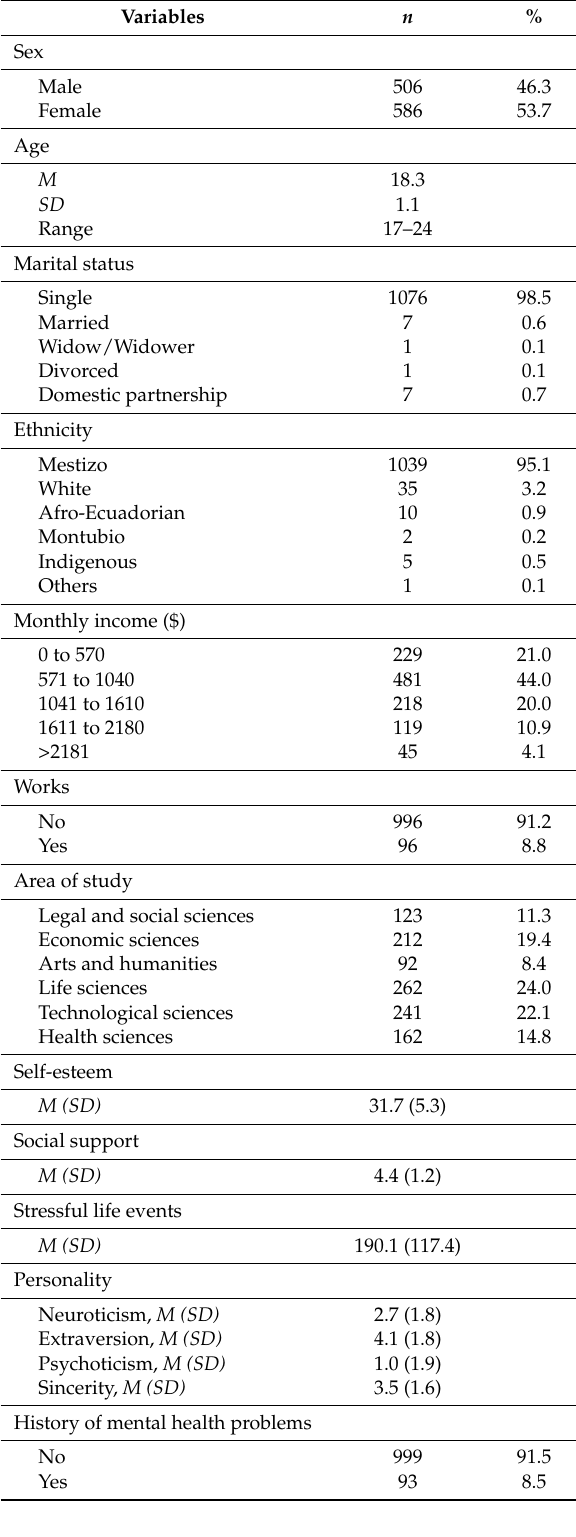
Table 1. Socio-demographic, academic and clinical